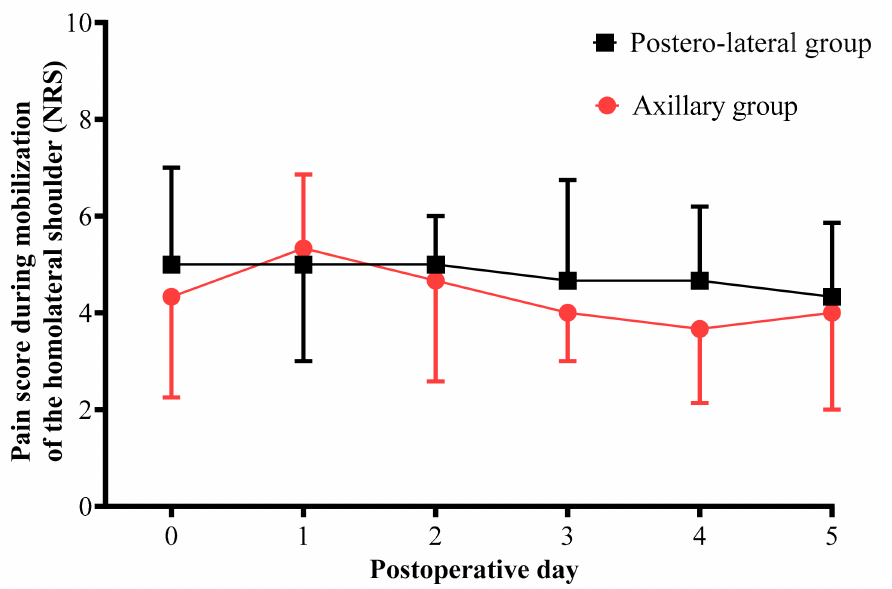
Figure 2. Comparison of pain score for mobilization of the ipsilateral shoulder measured from the day of surgery to postoperative day 5 for each surgical technique. Black boxes represent median NRS in the posterolateral thoracotomy group. Red circles represent median NRS in the axillary thoracotomy group. Pain was evaluated using an 11-point numerical rating scale (NRS) from 0 = no pain to 10 = maximum imaginable pain.